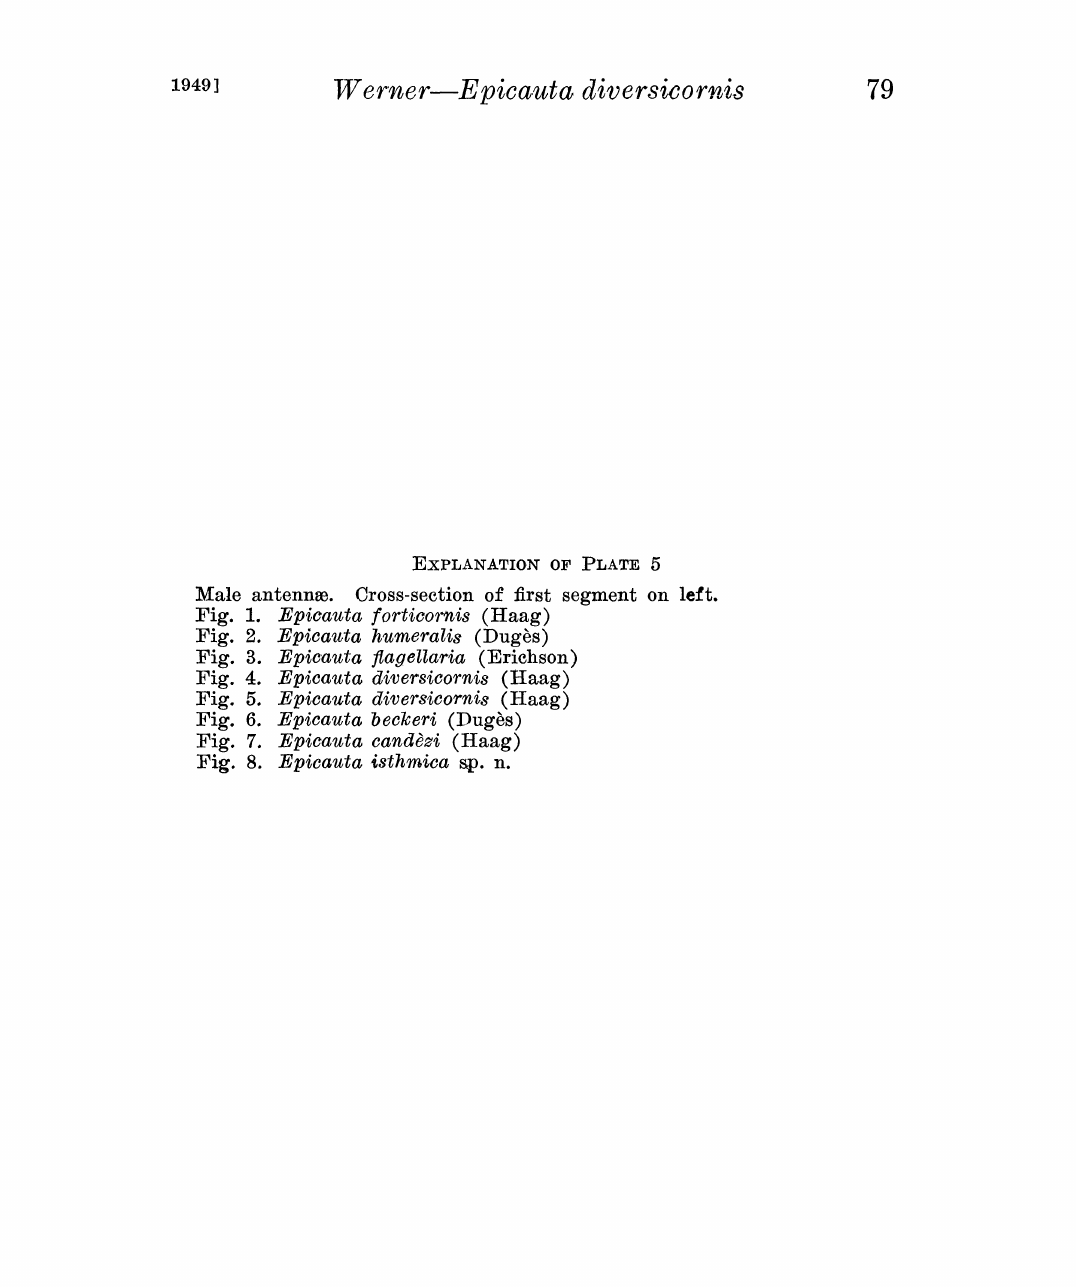
EXPLANATION OF PLATE YIale antennm. Cross-section of first segment on left. Fig. 1. Epicauta forticornis (Haag) Fig. 2. Fpicauta humeralis (Dug6s) Fig. 3. Fpicauta flagellaria (Erichson) Fig. 4. Epicauta diversicornis (ttaag) Fig. 5. Epicauta diversicornis (Haag) Fig. 6. Epicauta beckeri (Dugs) Fig. 7. Epicauta candzi (Haag) Fig. 8. Fpicauta isthmica so.